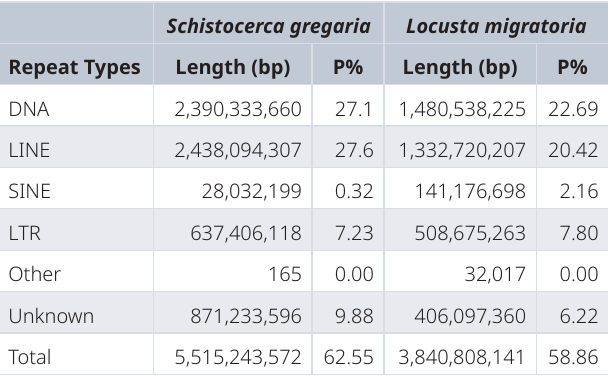
Table 2. Repetitive elements in the genomes of the desert locust, Schistocerca gregaria , and the migratory locust, Locusta migratoria (Wang et al. ,